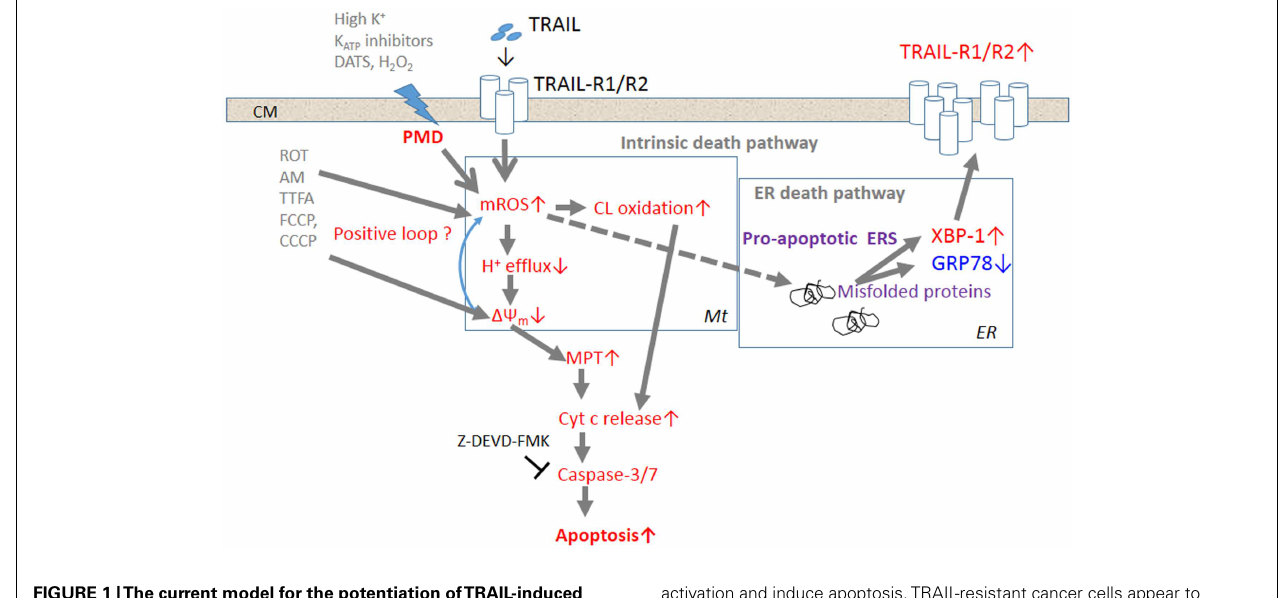
FIGURE 1 |The current model for the potentiation ofTRAIL-induced apoptosis in cancer cells by depolarization .Triggering ofTRAIL-R1 (DR4)/TRAIL-R2 (DR5) induces the generation and accumulation of mROS, leading to impairment of the ETC function and cardiolipin oxidation. Impairment of the ETC complex I/III function decreases H + efflux, thereby causing ∆Ψ m dissipation, i.e., MMD, and additional mROS generation and cardiolipin oxidation, thereby forming a positive loop. Cardiolipin oxidation and ∆Ψ m dissipation cooperatively promote the MPT and liberation of sufficient cytochrome c to trigger